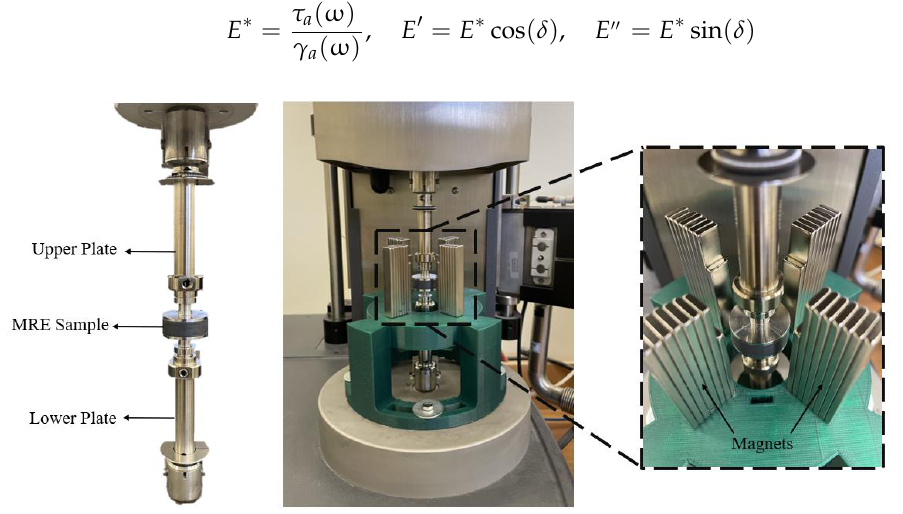
Figure 5. Dynamic Compression test of MRE samples on the dynamic mechanical analyzer.